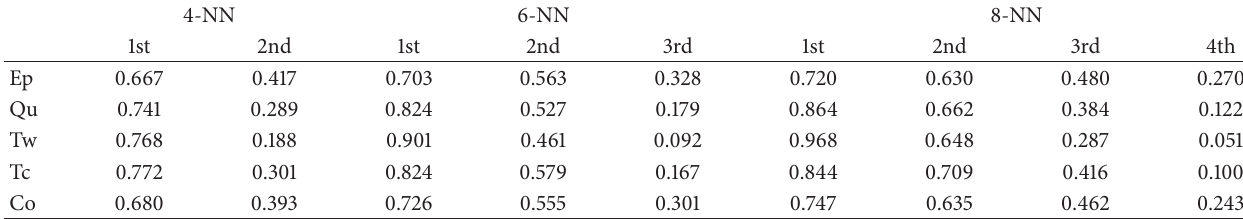
Table 6: Weighted values depending on day distance with each 𝐾 NN.